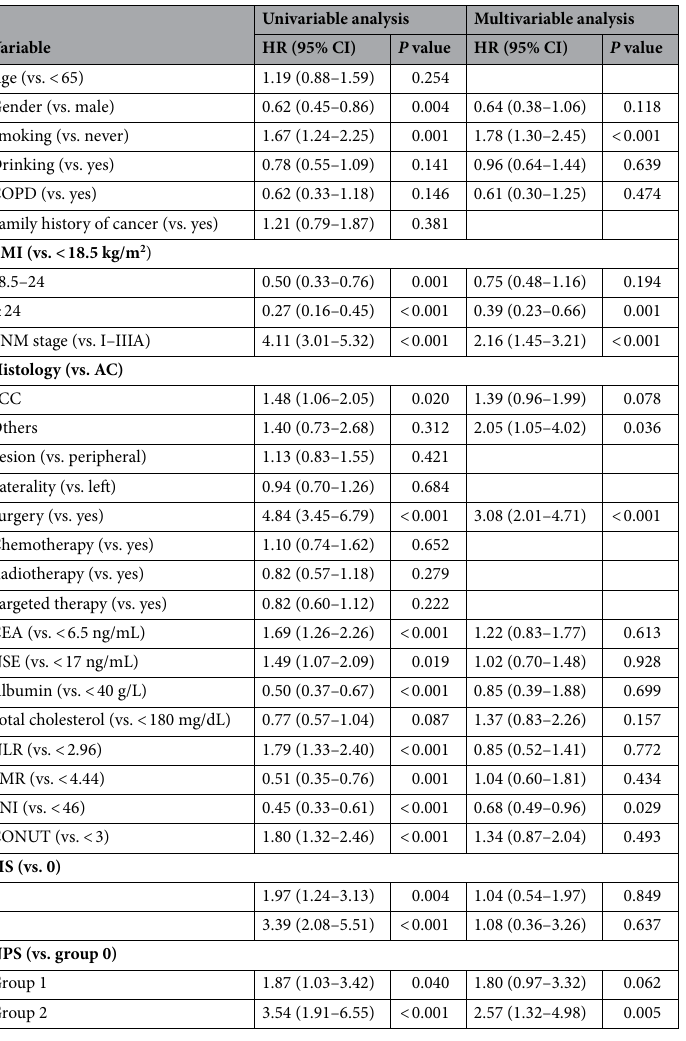
Table 3. Univariable and multivariable analysis of overall survival in NSCLC patients. AC adenocarcinoma, BMI body mass index, CEA carcinoembryonic antigen, CI confidence interval, CONUT controlling nutritional prognostic nutritional index, SCC squamous cell carcinoma, SIS system inflammation